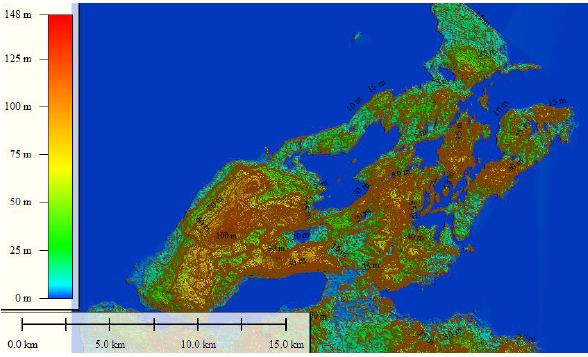
Figure 3. contouring in vegetation height of DSM